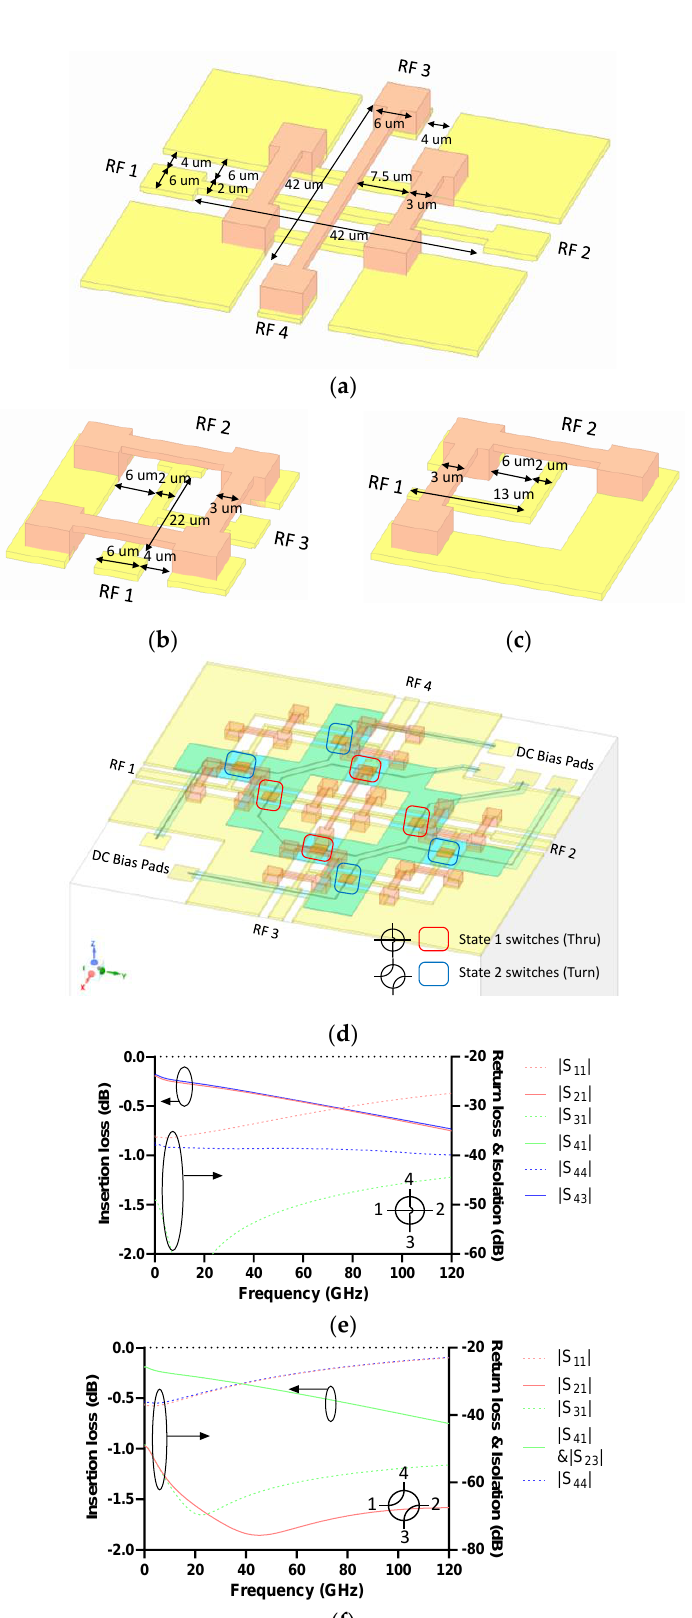
Figure 7. HFSS models of ( a ) a crossover, ( b ) a T-junction, ( c ) 90 ◦ turn, ( d ) a full model of the PCM semi-T switch based on SPST switches grouped by thru and turn operational states, ( e ) thru-state, and ( f ) turn-state simulations